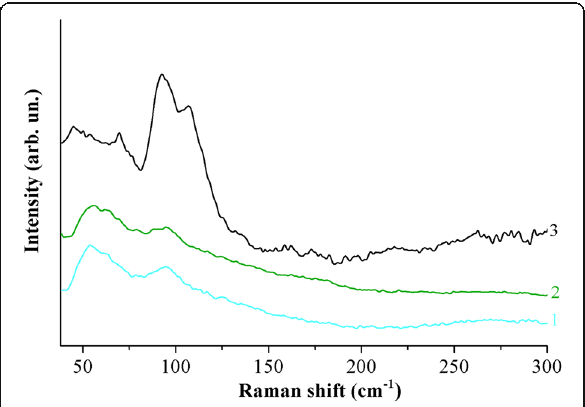
Fig. 7 Raman spectra of the films formed of the solution of PbI 2 and CH 3 NH 3 I compounds in DMF in the ratio (1:3) at temperatures of 100 (1), 150 (2), and 180 °C (3). All spectra were obtained with λ exc = 532 nm at room